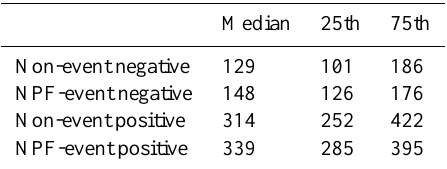
Table 1. Median, 25th and 75th percentile of cluster ion concentra- tions [cm − 3 ] (diameter < 1 . 6nm) during 8 selected NPF event and 13 non-event days, measured with the NAIS during summer 2012 at the Waldstein